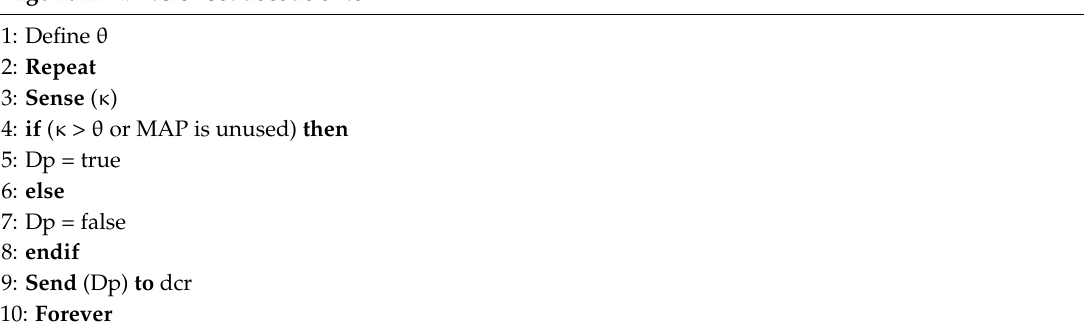
Algorithm 1: Basic Pseudocode of tc